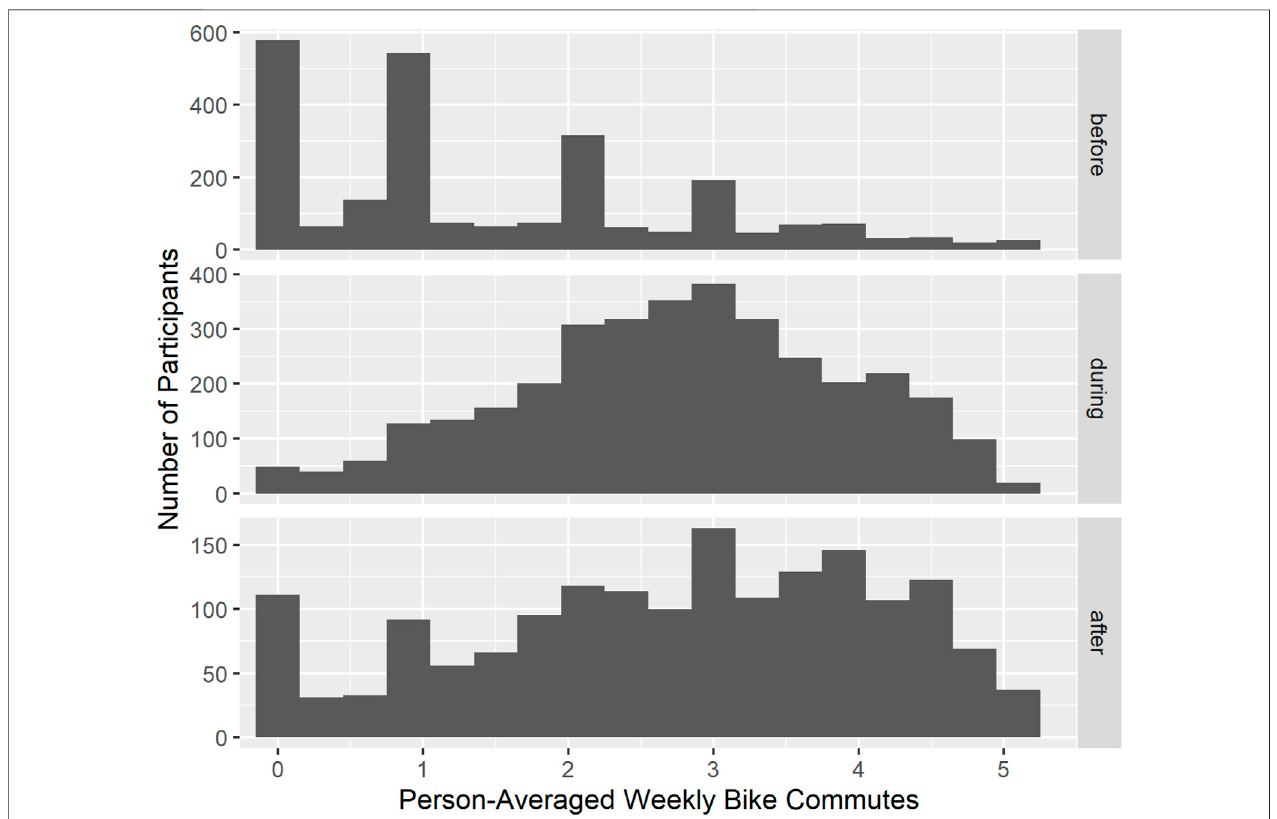
FIGURE 3 | Histograms of person-level average weekly morning bike commutes by project